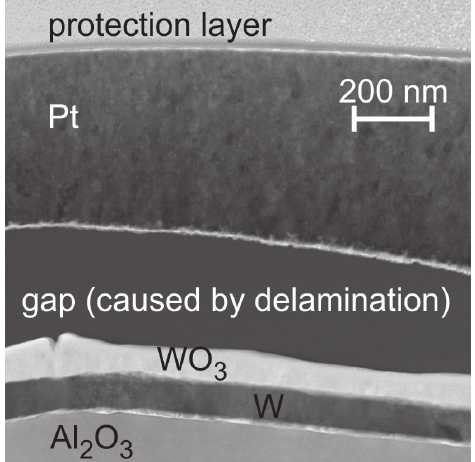
Figure 6. HAADF STEM image (chemical contrast) of the Pt ∗ film on W seed layer after annealing at 400 ◦ C in air. Due to the high thickness of the TEM lamella the absorption of the electrons in the Pt ∗ and W layers plays an important role leading to the dark appearance of W and Pt and to the brighter appearance of the WO 3 layer and Al 2 O 3